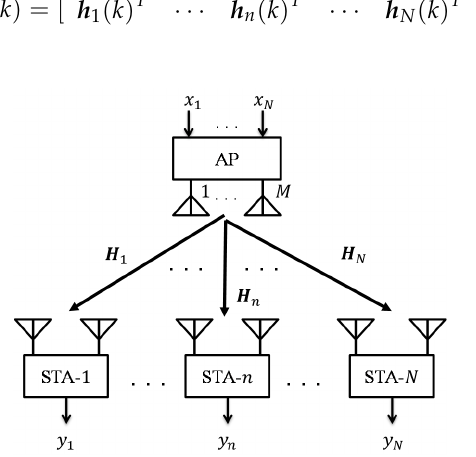
Figure 1. System model in which the access point (AP), using M antennas, communicates with N stations (STAs) using two antennas on the downlink multiuser multiple input multiple output orthogonal frequency division multiplexing (MU-MIMO-OFDM) transmission.